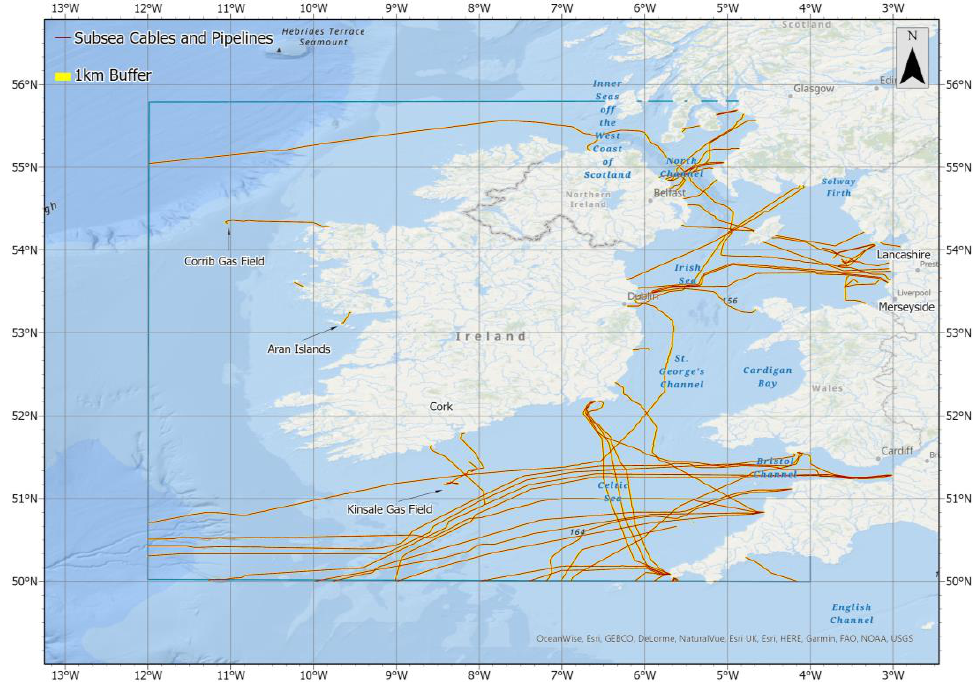
Figure 19. The busiest 20% (orange) and 10% (red) areas for fishing in the Selkie study area based on a three-year time series of AIS data (h/km 2 /month).